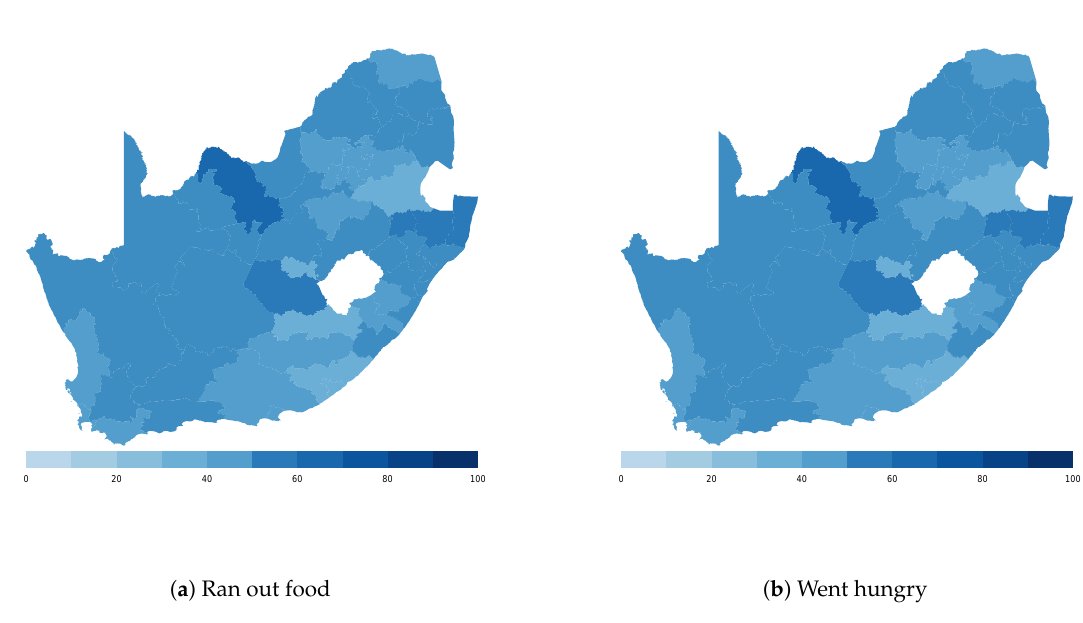
Figure 9. Nigeria—share of households.